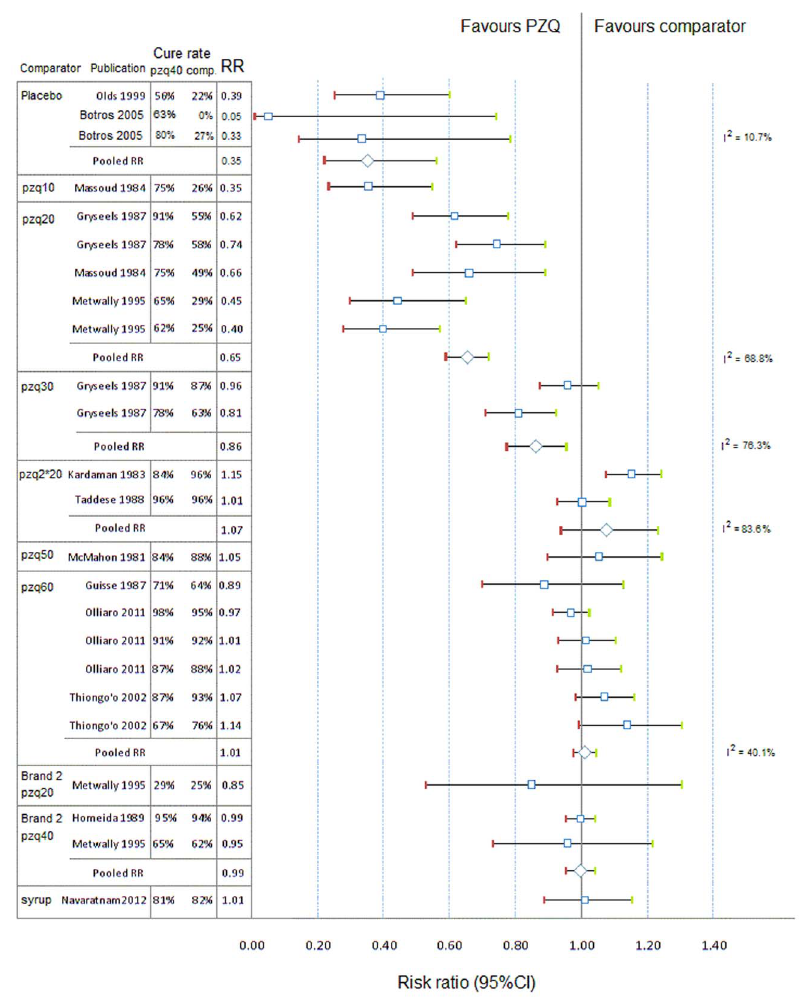
Figure 4. Forest plot of risk ratios of cure rates with 95%CIs, S.mansoni , PZQ 40 mg/kg vs. other PZQ regimens. comp, comparator; ci, confidence interval; pzq, praziquantel; unit next to the drug: dose in mg/kg; RR, risk ratio; I 2 (Higgins’ I squared) is calculated for pooled subgroups as = 100% 6 ( Q - df)/ Q , where Q is Cochran’s heterogeneity statistic and df the degrees of freedom.